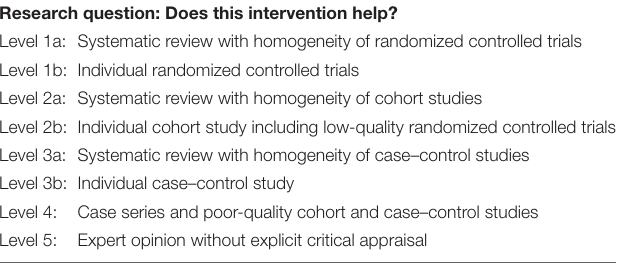
TABLE 1 | Levels of evidence for practical